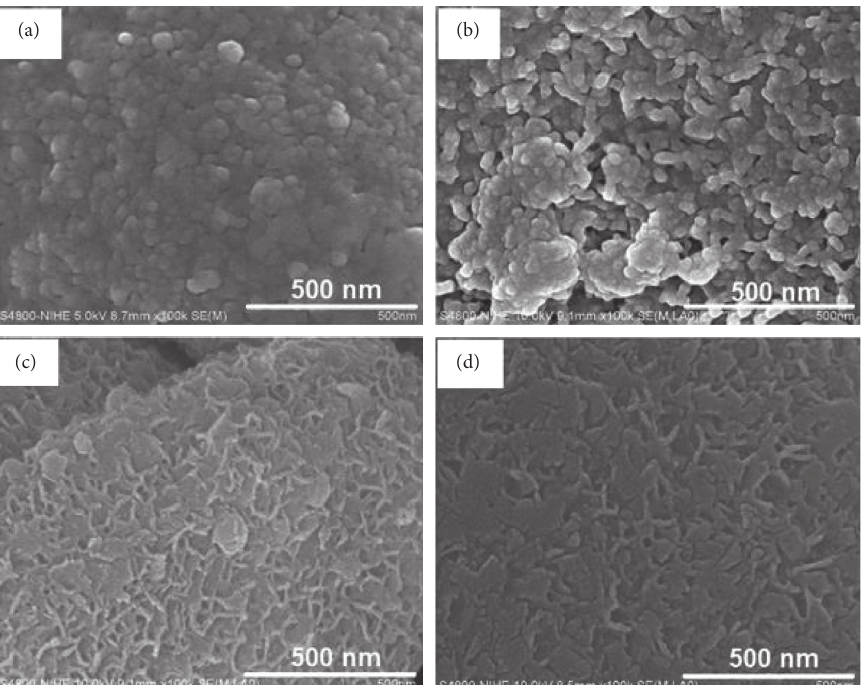
Figure 3: FESEM images of FA0 (a), FAN (b), FAMBT (c), and FASDS (d) particles at the magnification of 100.000 times.